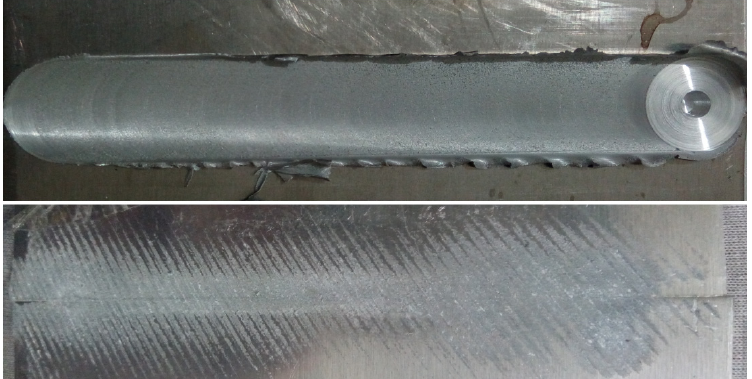
Figure 11. The top and bottom views of welded specimen due to optimum situations. Table 7. The statistical and experimental UTS magnitudes of optimized model.